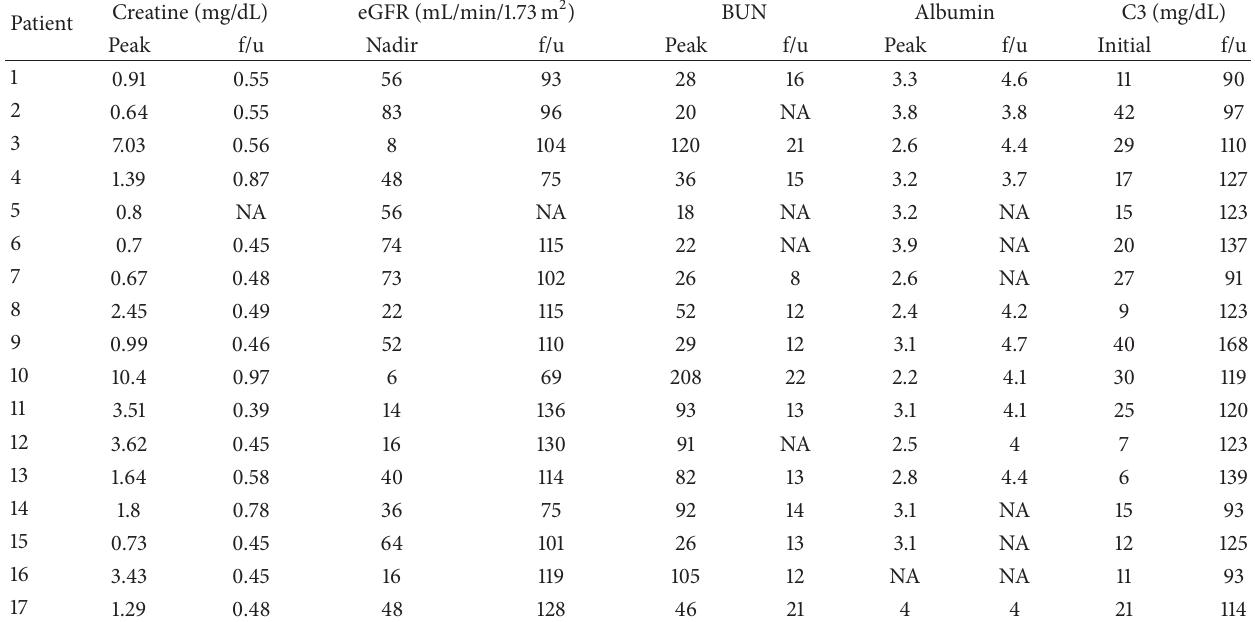
Table 3: Serum lab results during acute PSGN and at follow-up.